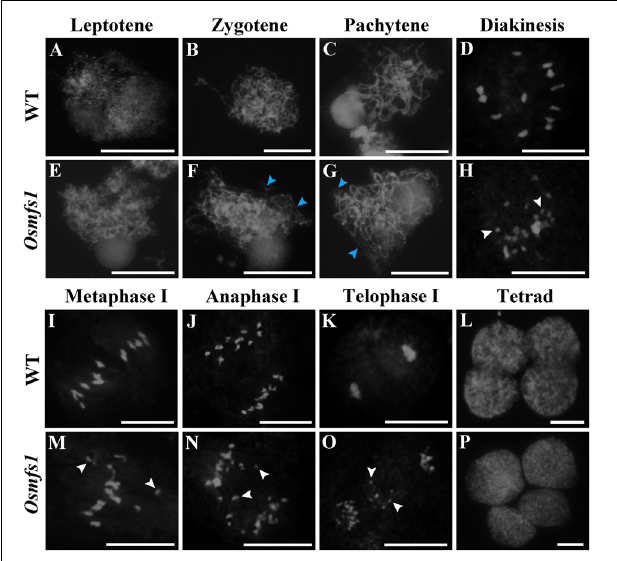
FIGURE 5 | Meiotic chromosomes spreads of pollen mother cells in the WT and the Osmfs1 mutant. (A–D, I–L) WT. (E–H, M–P) Osmfs1 . (A,E) Leptotene. (B,F) Zygotene. (C,G) Pachytene stage. (D,H) Diakinesis. (I,M) Metaphase I. (J,N) Anaphase. (K,O) Telophase. (L,P) Tetrad. The blue arrows point to the unpaired chromosomes, the white arrows point to univalents. Bars = 100 µ m.